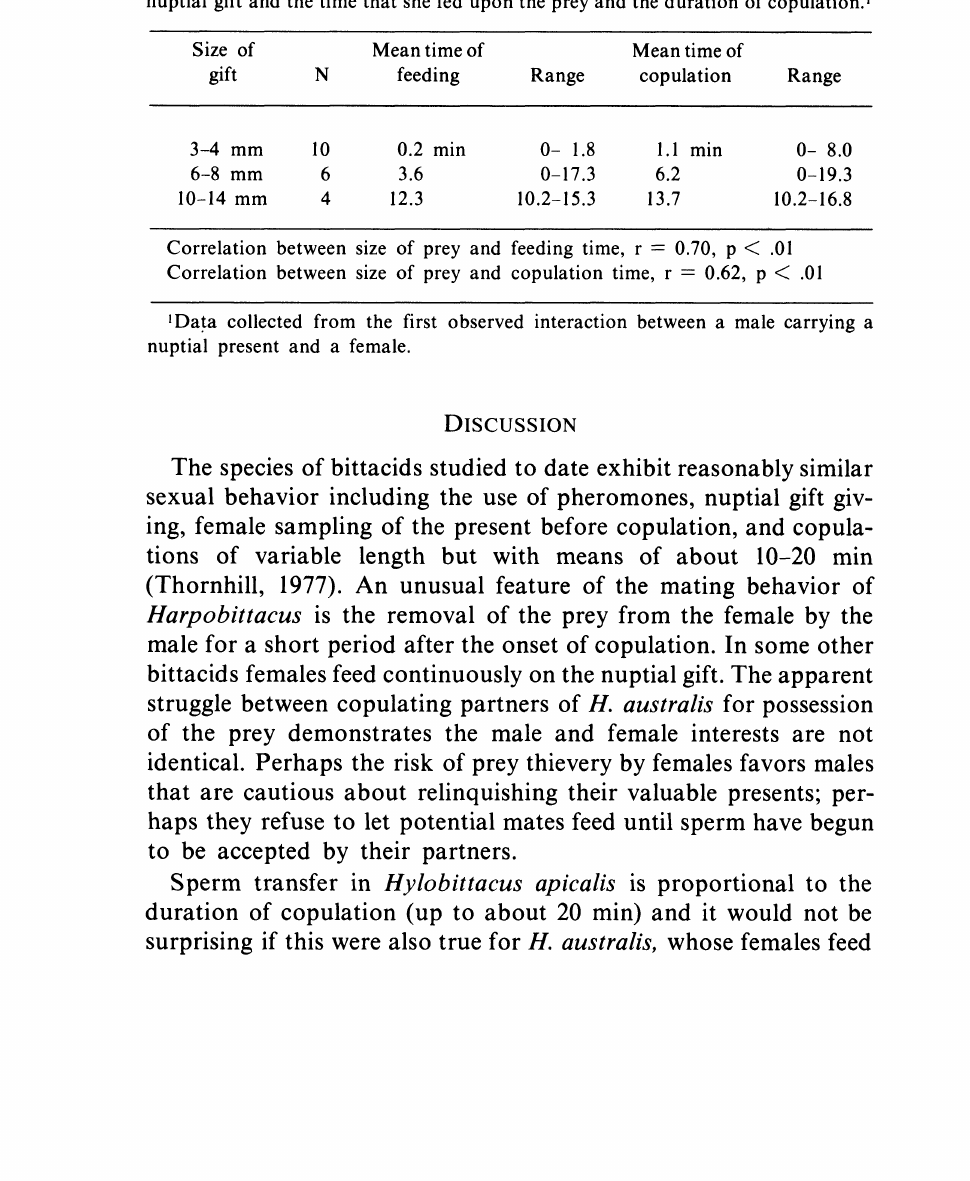
Table I. The relation between the estimated length of the prey offered a female as a nuptial gift and the time that she fed upon the prey and the duration of copulation. Size of Mean time of Mean time of gift N feeding Range copulation Range 3-4 mm 10 0.2 min 0- 1.8 1.1 min 0- 8.0 6-8 mm 6 3.6 0-17.3 6.2 0-19.3 10-14 mm 4 12.3 10.2-15.3 13.7